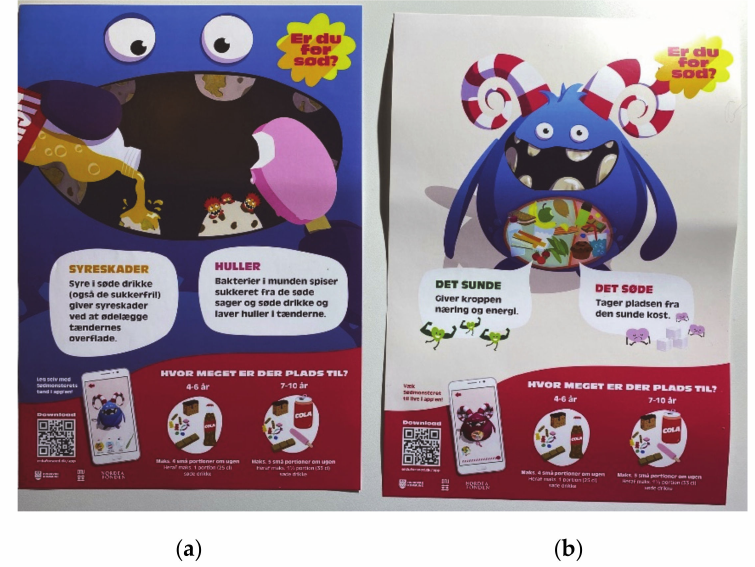
( a ) the dentists; ( b ) school health